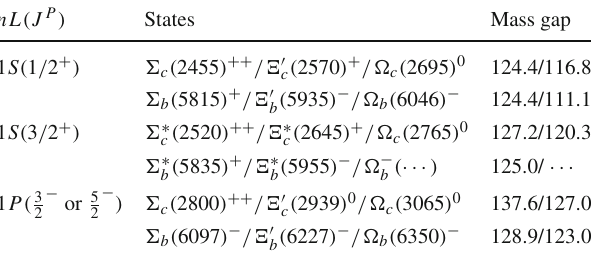
Table 3 The observed (cid:10) Q , (cid:3) (cid:3) , and (cid:11) Q baryons [49,60] and the cor- Q responding mass gaps involved in these states (in MeV). In the last column, there are two values for each line, where the first value is the mass gap of the first and the second states listed in the second column, and the second value denotes the mass difference of the second and the ( ··· ) denotes the absent 1 S (cid:11) − ( 3 / 2 + ) state in third states. Here, (cid:11) − b b the